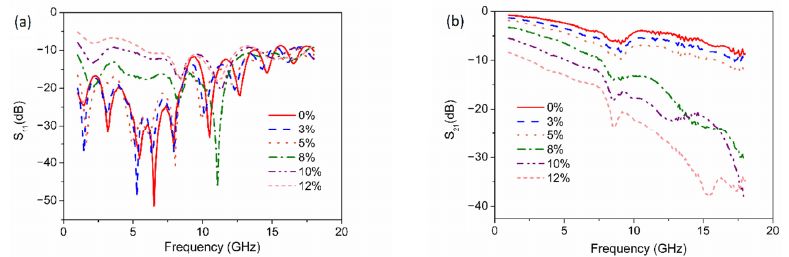
Figure 4. The measured S-parameters under various strain: ( a ) S 11 spectra; ( b ) S 21 spectra.